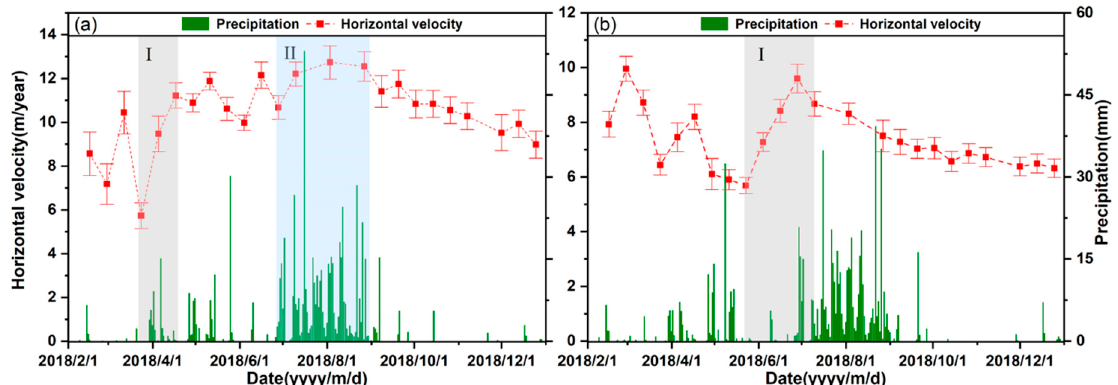
Figure 9. Correlation between glaciers horizontal velocities and precipitation in 2018. ( a ) point P2 at glacier No.1; ( b ) point P4 at glacier No.2. Locations of points P2 and P4 are shown on Figures 6 and 7, respectively. The error bars indicated by the STD of the average 3 × 3 pixels in horizontal direction.